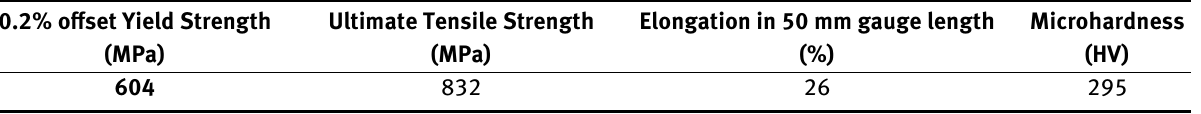
Table 2: Mechanical properties of AHSS-DP800 steel 0.2% offset Yield Strength